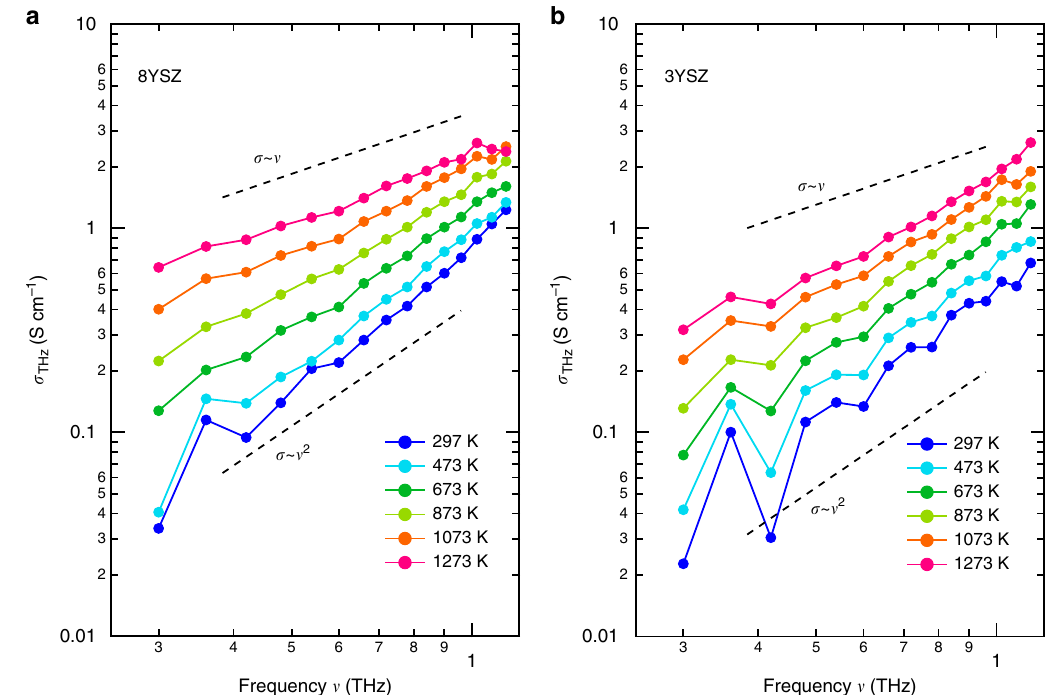
Fig. 3 THz conductivities of 8YSZ and 3YSZ. a The real parts of the optical conductivities of 8YSZ and b those of 3YSZ at different temperatures. The dashed lines represent the linear and quadratic dependences for